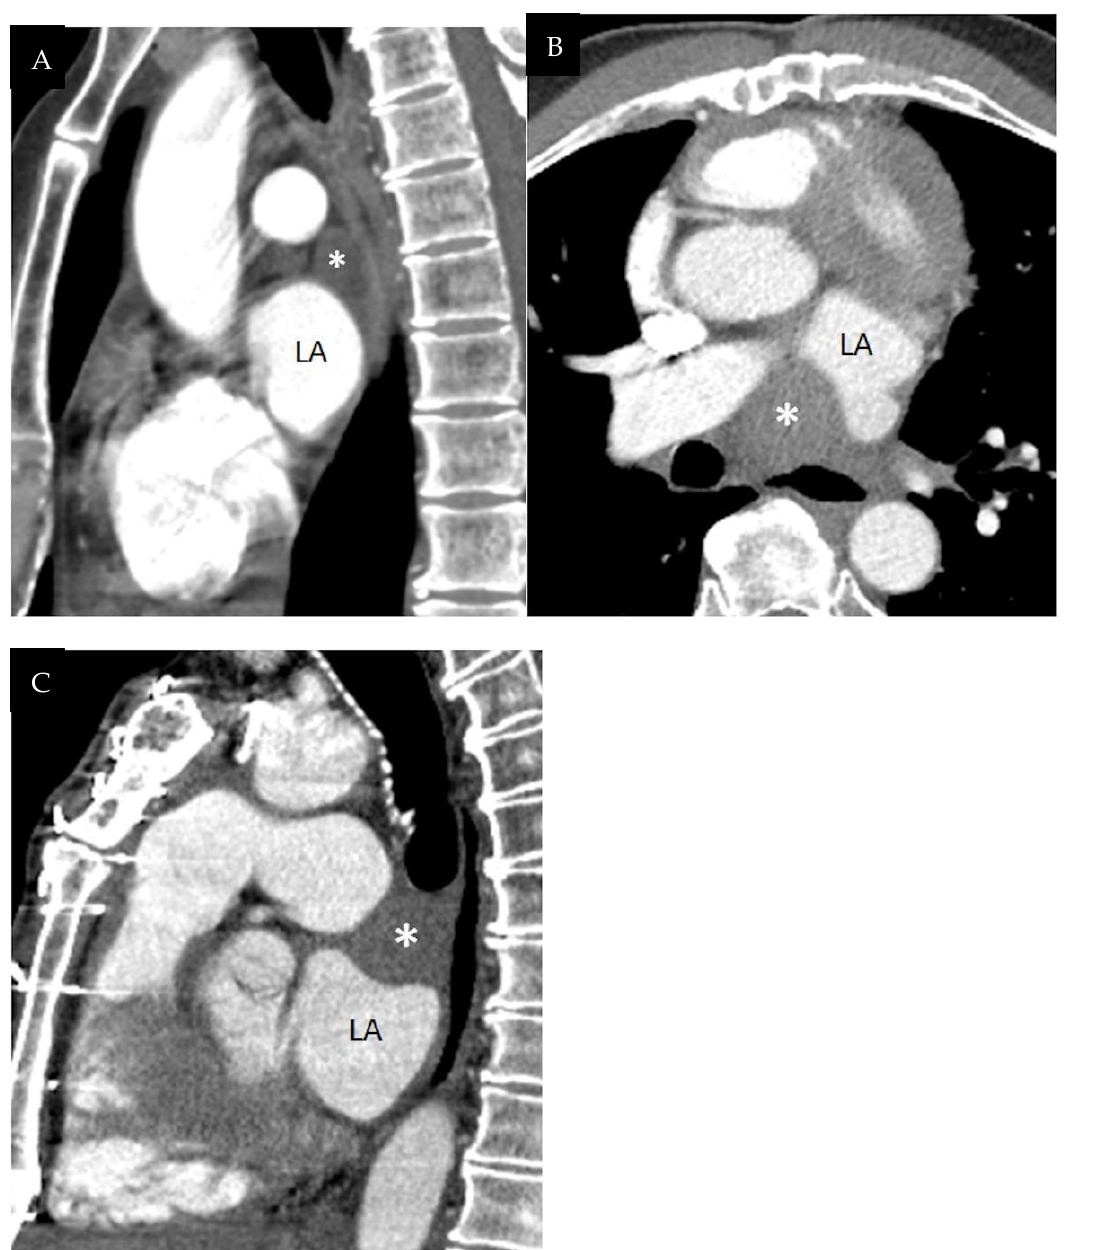
The pericardial cavity proper gives rise to three recesses: right and left pulmonary venous recesses and the postcaval